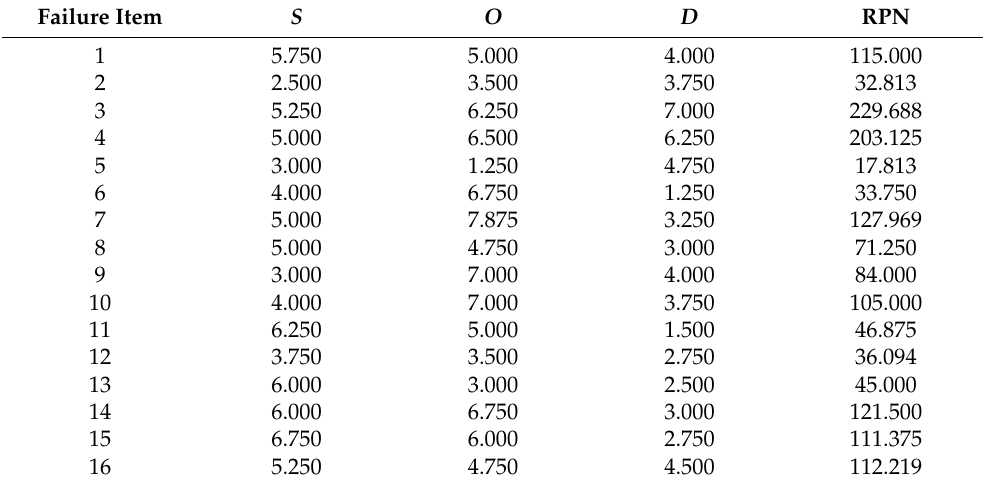
Table 6. The results of risk priority number (RPN)